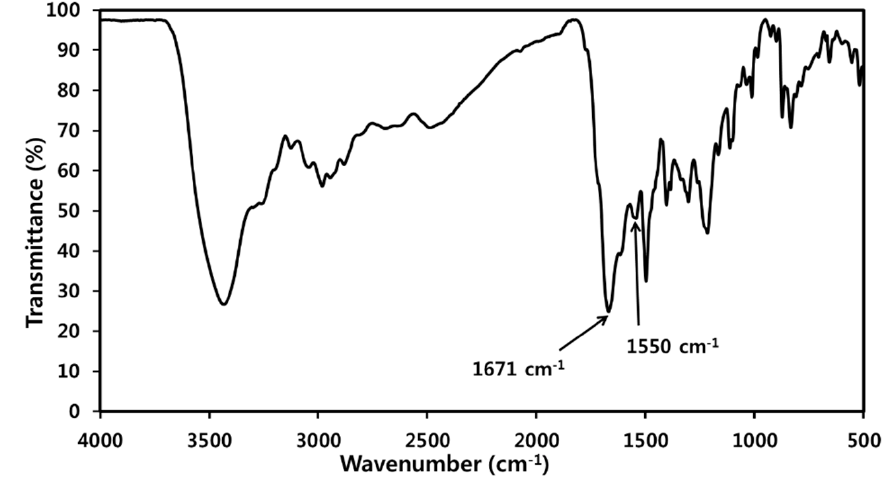
Figure 2. FT-IR spectrum of PMDA-ODA poly(amic acid) salt (PAAS).